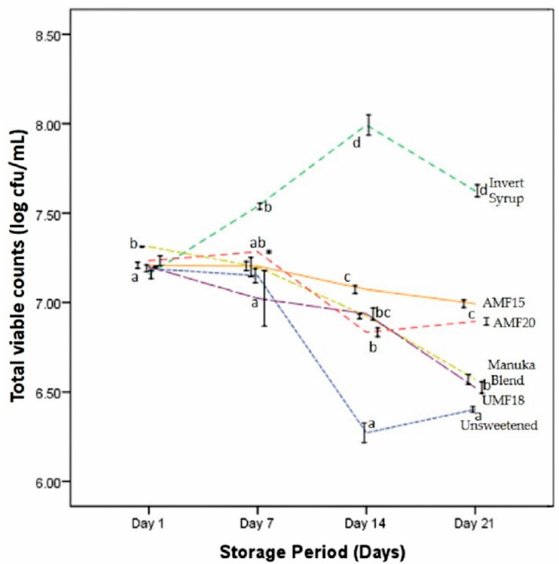
Figure 1. Lactic acid bacteria (LAB) counts (log colony forming units / mL) in yogurts with Manuka honey (Blend, UMF TM 18 + and AMF TM 15 + ), invert syrup, and unsweetened control, during the refrigerated storage period (21 days). Different lowercase letters indicate significant differences ( p < 0.05) among the yogurt samples (on that particular day). Error bars represent standard error of means (±1 SE). The addition of AMF15 manuka honey to the yogurt maintained a high probiotic survival (7.0 log cfu/mL) after the three-week refrigerated storage (4 °C). The counts were significantly ( p < 0.01) higher than those for the MB (6.57 log cfu/mL), UMF18 (6.52 log cfu/mL) and the control sample